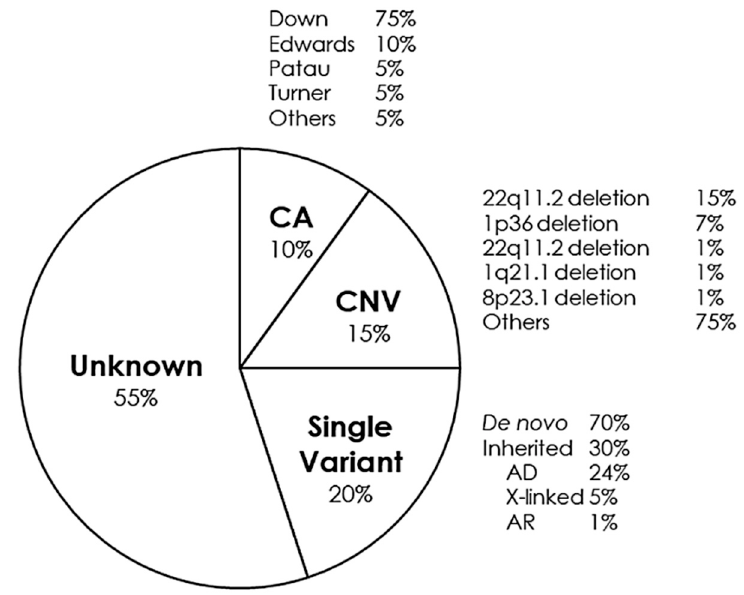
Figure 2. Genetic distribution of congenital heart defects. AD, Autosomal Dominant; AR, Autosomal Recessive; CA, Chromosomic Alterations; CNV, Copy Number